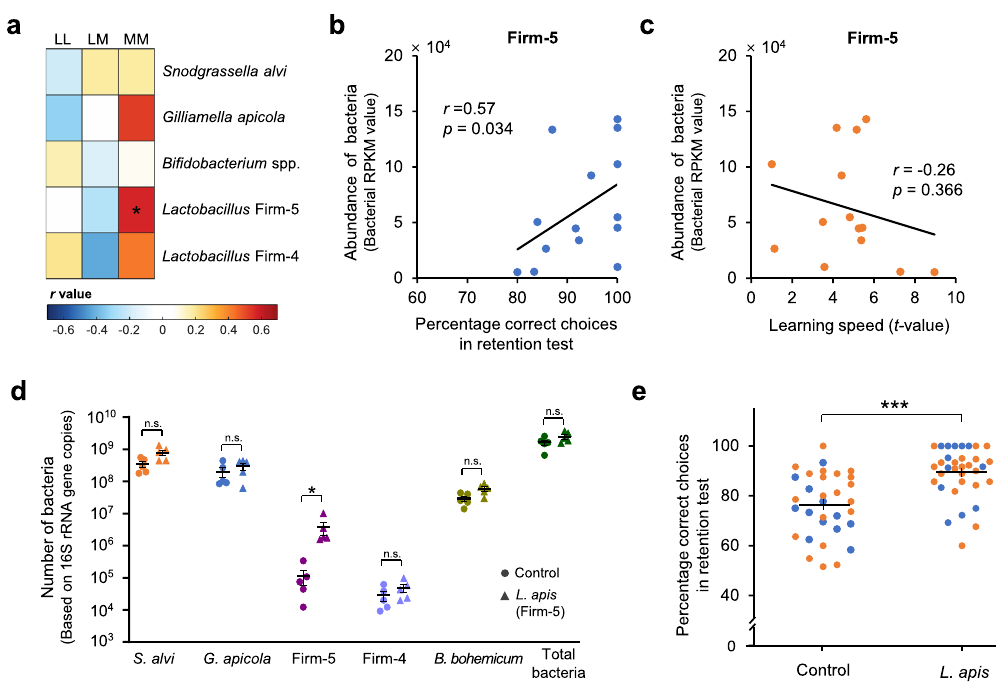
Fig. 2 Individual long-term memory retention correlates with the abundance of bee gut microbes, and L. apis supplementation enhances long-term memory. a The correlations between learning speed/memory retention and the abundance of bacterial phylotypes. Colours indicate the coef fi cient r values from two-sided Spearman correlation analyses (* p = 0.034). Bonferroni corrected p values for all spearman correlations are shown in Supplementary Data 3. LL learning speed in the Learning group ( n = 15 bees), LM learning speed in the Memory group ( n = 14 bees), MM memory performance in